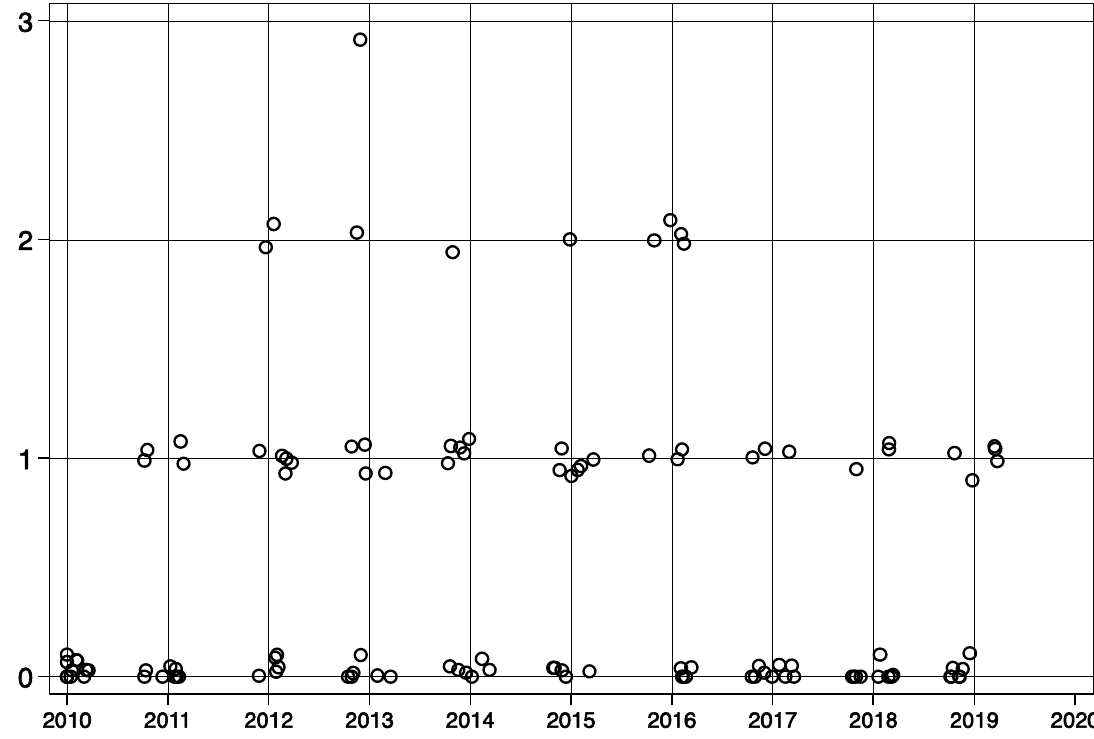
Figure A4. Securitization dynamics in Italy (number of securitizations in which a bank was